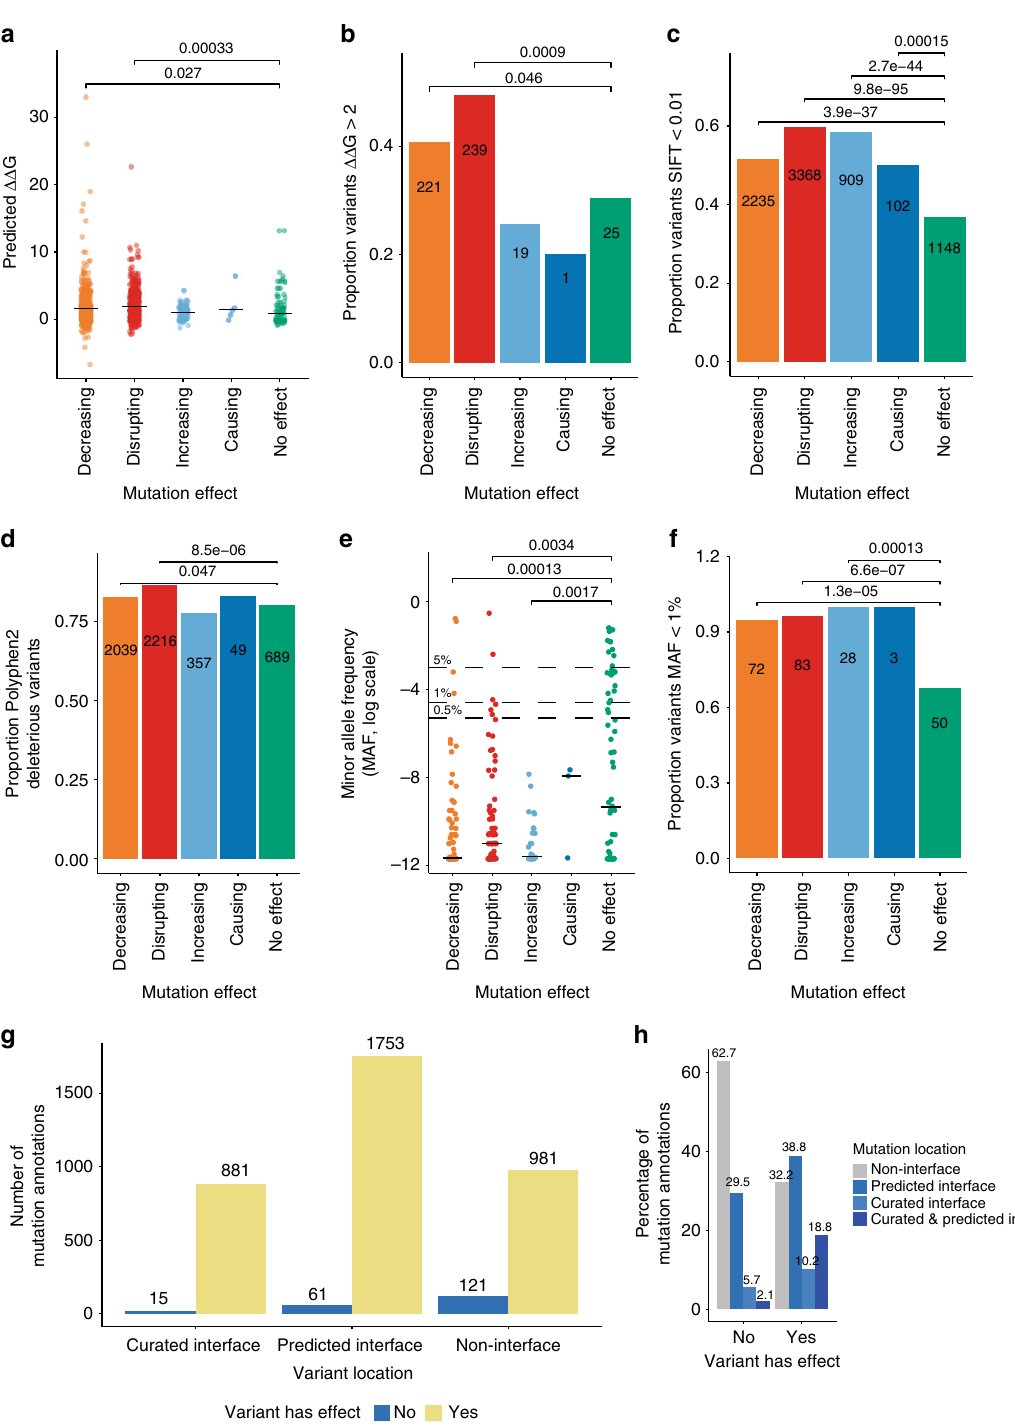
Fig. 4 Computational annotations and the IMEx mutations data set. a Interaction interface disruption as predicted with FoldX, by mutation effect type. Indicated p -values calculated with Wilcoxon test (decreasing vs no effect W = 25,100; disrupting vs no effect W = 24,411); b Proportion of highly disruptive variants by mutation effect type; c Proportion of low tolerance residue positions according to the SIFT, by mutation effect type; d ExAC-extracted allele frequencies for mutations represented in the IMEx data set, by mutation effect type; e Low frequency variants, by mutation effect type. Indicated p -values calculated with Wilcoxon test (decreasing vs no effect W = 1841.5; disrupting vs no effect W = 2389.5; increasing vs no effect W = 645); f Proportion of deleterious substitutions according to Polyphen2, by mutation effect type; g Number of mutation annotations located in binding interfaces (curated and predicted), by effect; h Normalized frequencies of mutation annotations reporting effects over interactions or not and their localization in binding interfaces. p -values indicated in panels b , c , d and f were calculated with Fisher exact test. Source data are provided as a Source Data fi